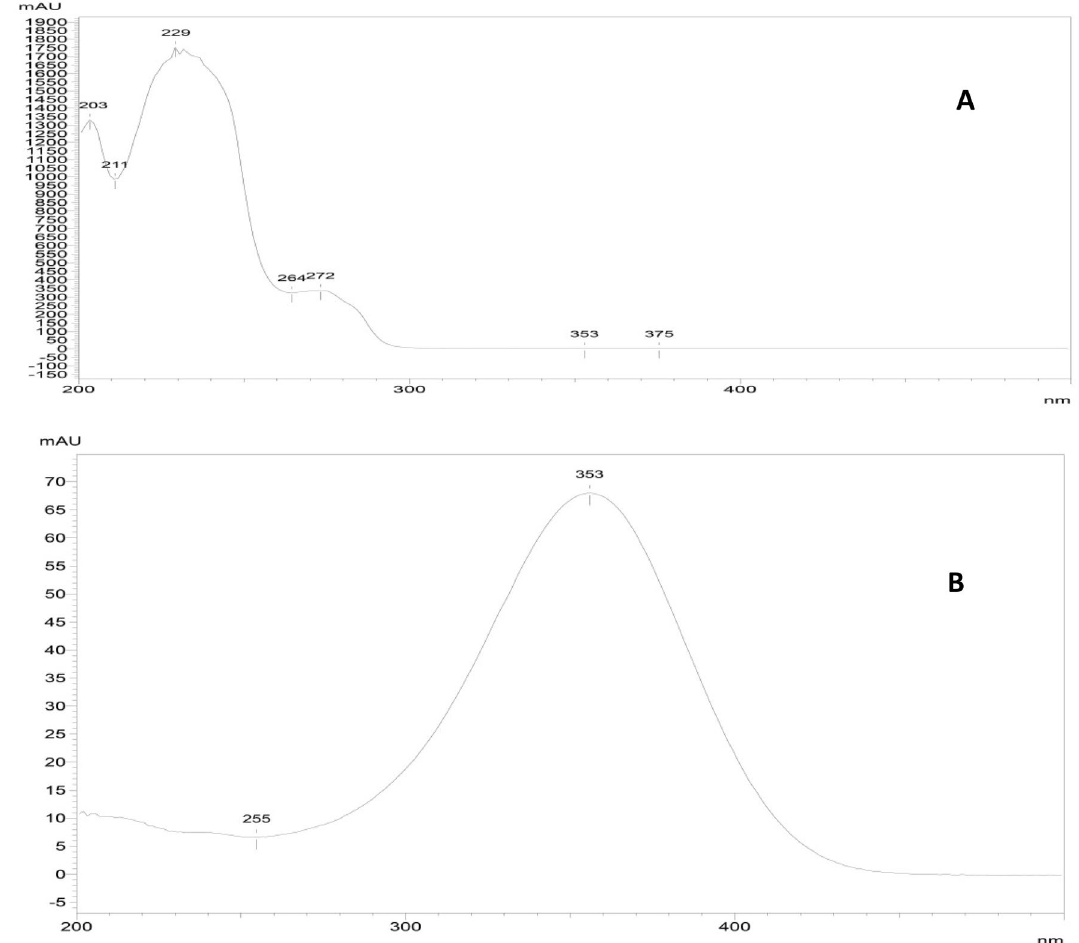
Fig. 2 UV Spectrum of A Benzoyl Peroxide, B Tretinoin